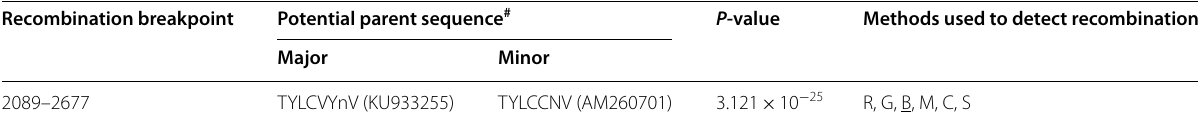
Table 1 The region in the CoYVV genome corresponding to the recombination breakpoint detected by at least six different methods in the RDP4